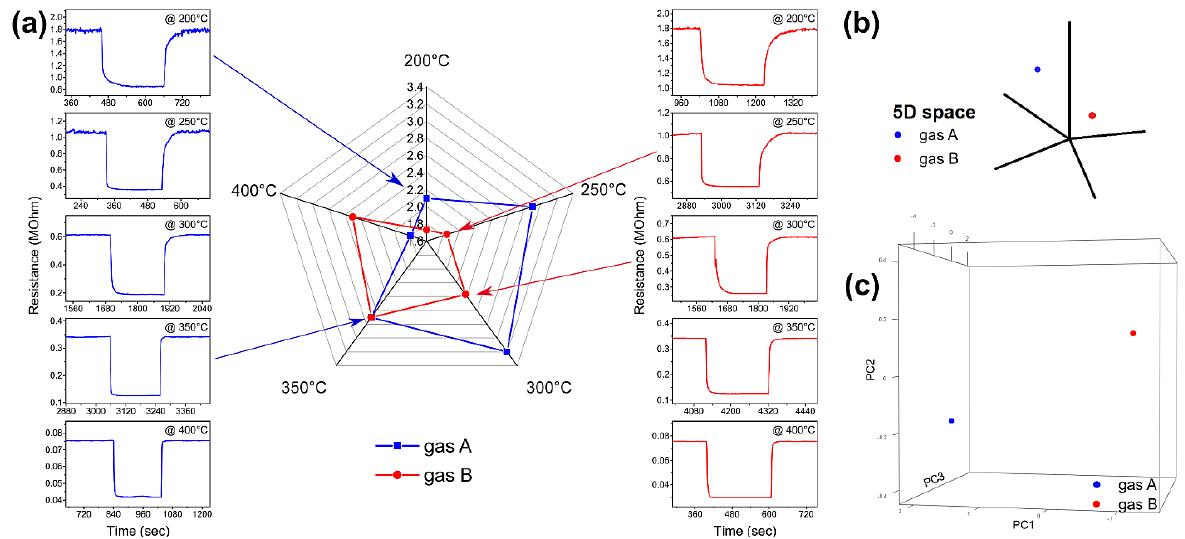
Figure 3. Procedure for combining the five sensor responses at different temperatures: ( a ) the responses calculated in the five graphs in each column (blue and red) are combined into a radar plot (blue and red, respectively); ( b ) the five response values become a five-dimensional point; ( c ) which, in our case, is reduced to three dimensional by PCA.